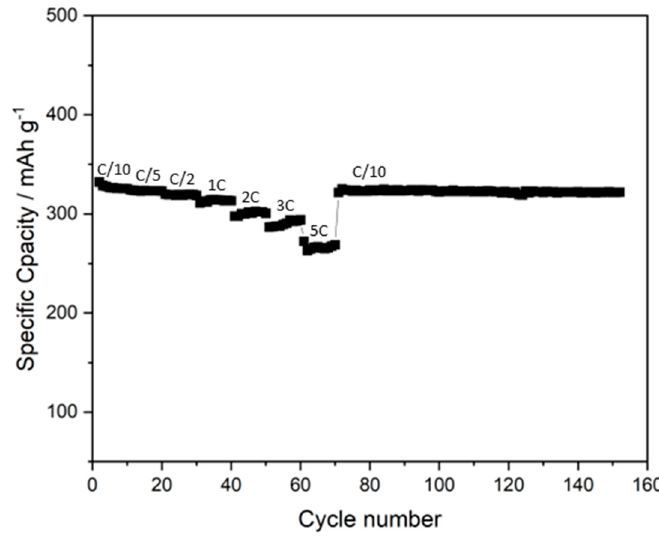
Figure 3. Discharge-specific capacity of the 5L anode obtained by printing ball-milled ink for three hours at 25 wt% of dry content at variable and constant rates.